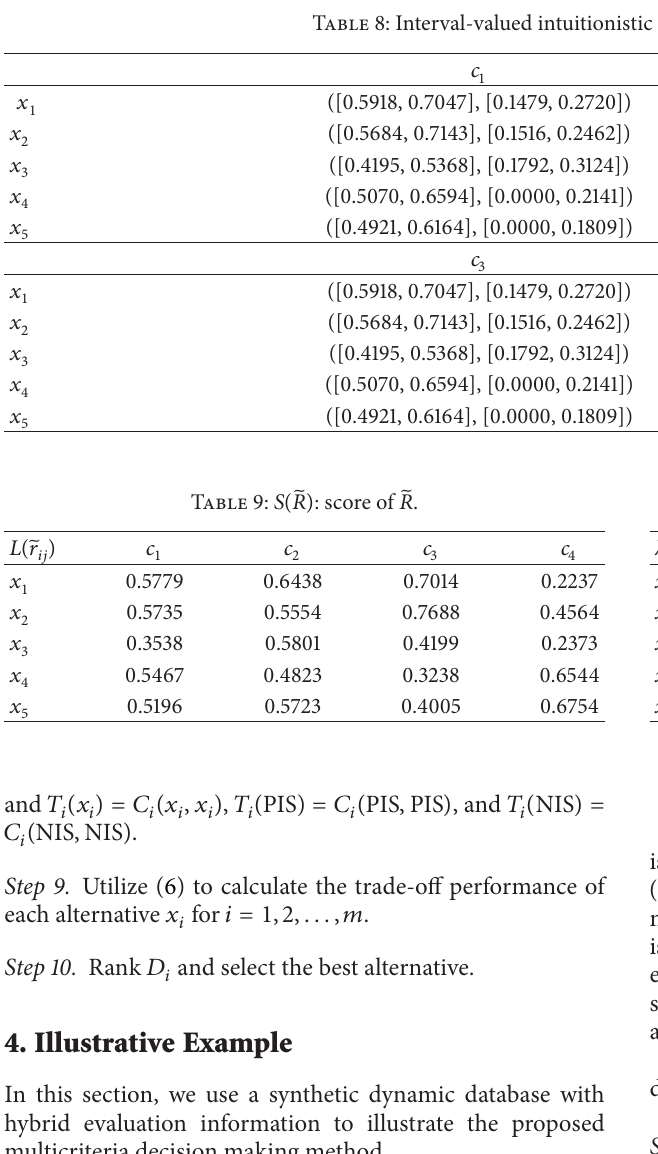
Table 8: Interval-valued intuitionistic fuzzy evaluation information